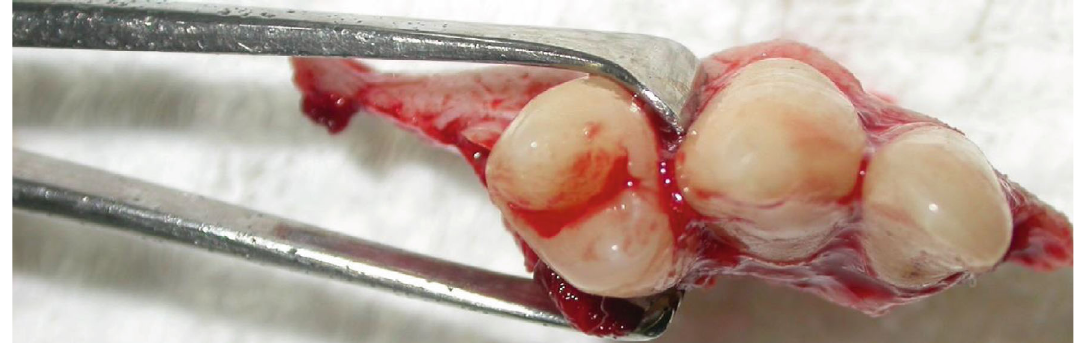
Figure 4: Occlusal view of the premaxilla alveolar fragment.